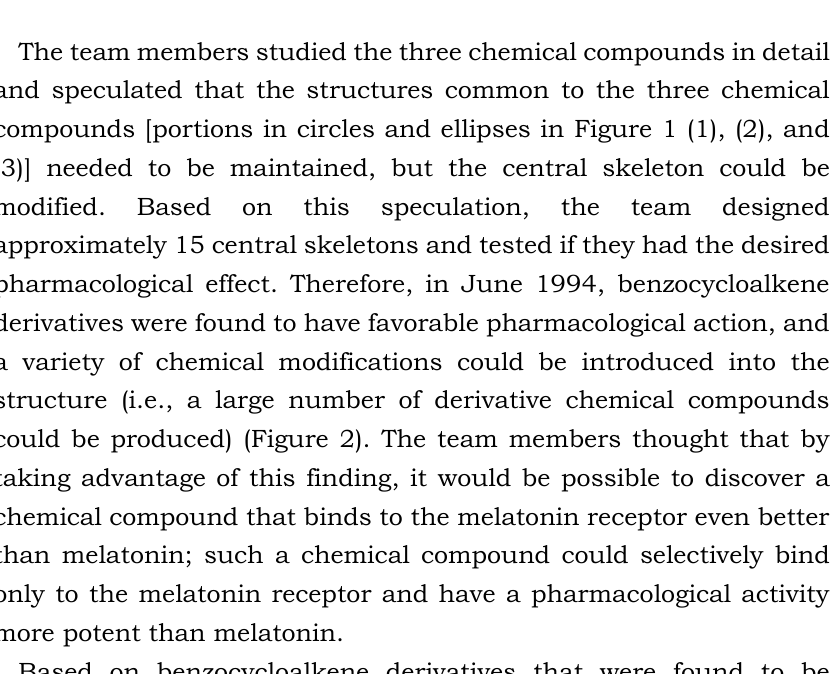
Figure 1. Structure of melatonin receptor agonists Source: Uchikawa and Okawa